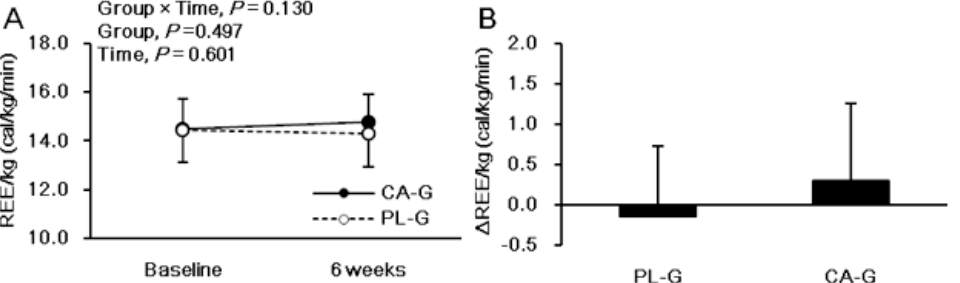
Figure 3. Mean ( ± SD) REE / kg at baseline and at 6 weeks after ingestion of capsinoid ( • ) and placebo Figure 3. Mean (± SD) REE/kg at baseline and at 6 weeks after ingestion of capsinoid ( ● ) and placebo ( ○ ) in all ( ) in all participants ( n = 38) ( A ). Mean ( ± SD) changes in REE / kg after the 6-week intervention in all participants ( n = 38) ( A ). Mean (± SD) changes in REE/kg after the 6-week intervention in all participants ( n = 38) (cid:35) ( B ). There were no significant intervention interactions (group × time, P = 0.130) or main effects on the group ( P = 0.497) or the time ( P = 0.601) according to the ANOVA ( A ) results. A Welch test was conducted which indicated that there was a significant difference between the CA-G and PL-G ( B ). CA-G, capsinoid group; PL-G, placebo group; REE/kg, resting energy expenditure per kg.